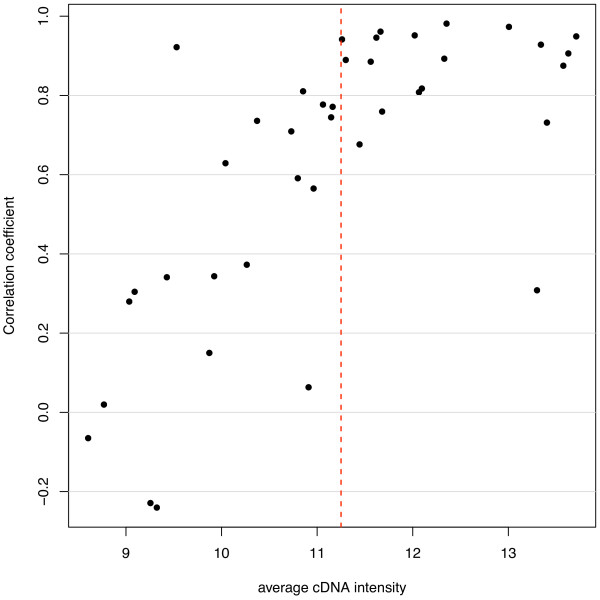
Correlation of Sequenom and Illumina allele quantification. Pearson's correlation coefficient (r) is calculated for the allele-specific quantification on the two platforms and plotted against cDNA intensity (average log2 fluorescence for the 23 placentas) on Illumina. The correlation drops when cDNA average intensity is lower than the 11.25 cut-off (dashed red line).